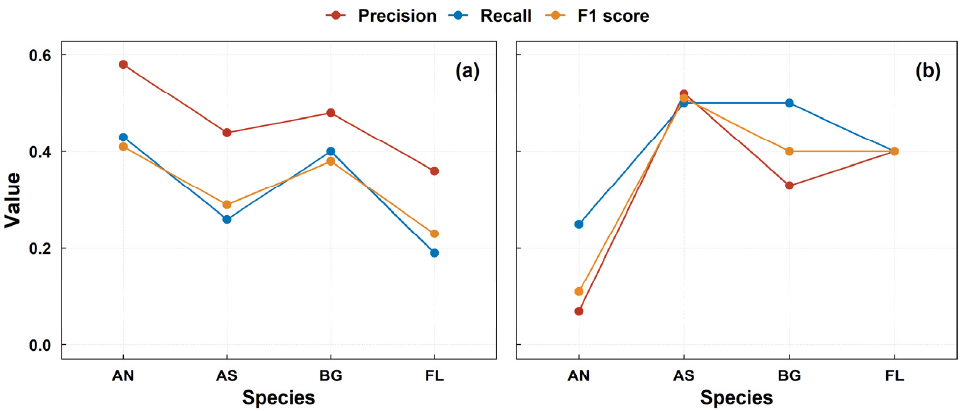
Figure 9. The specific accuracy of tree crown detection for different tree species using the transfer- trained DeepForest ( a ) and Detectree2 ( b ) methods. AN, AS, BG, and FL represent Acer nipponicum , Acer shirasawanum , Betula grossa , and Fraxinus lanuginose , respectively.